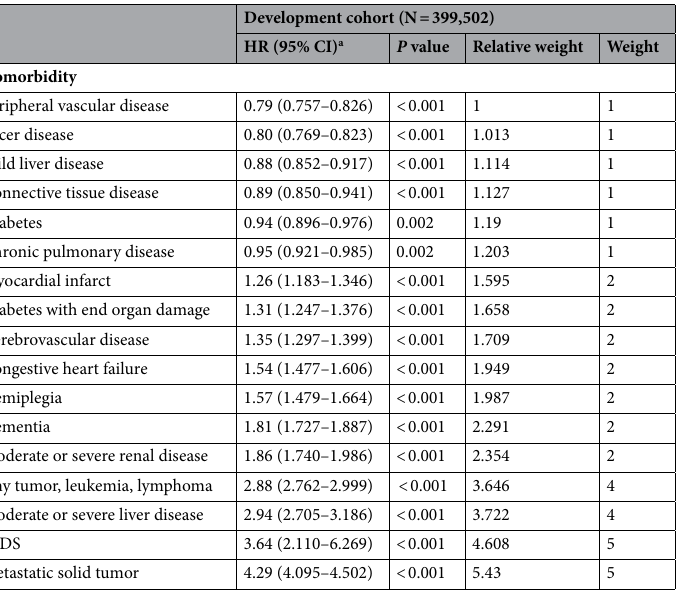
Table 3. Weights for comorbidities in the development cohort. a Adjusted for age (10 groups), sex, region, family income ratio, and all